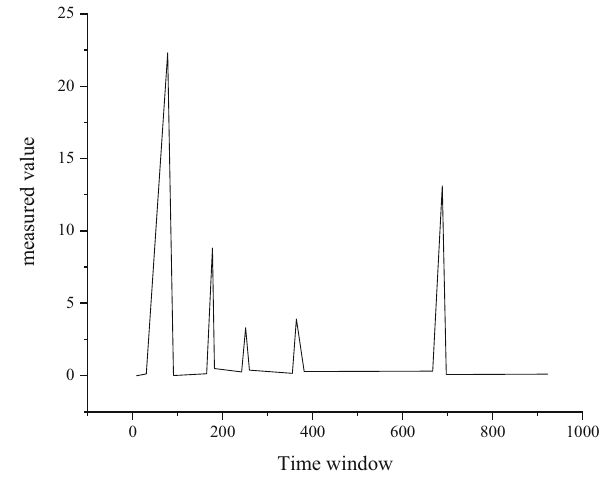
Figure 4: Change graph of attack index after scanning is reduced.